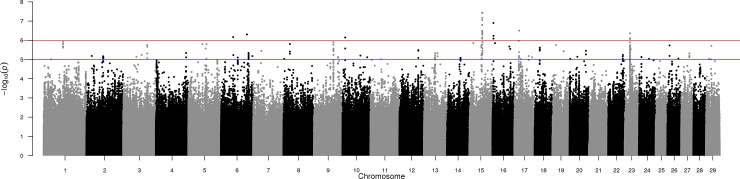
Manhattan plot showing–log10 (P-values) of association between each single nucleotide polymorphism effect and the weighted deregressed EBV for bovine tuberculosis infection in the multi-breed analysis of 7,346 bulls; red and blue lines represent genome-wide and suggestive thresholds, respectively.